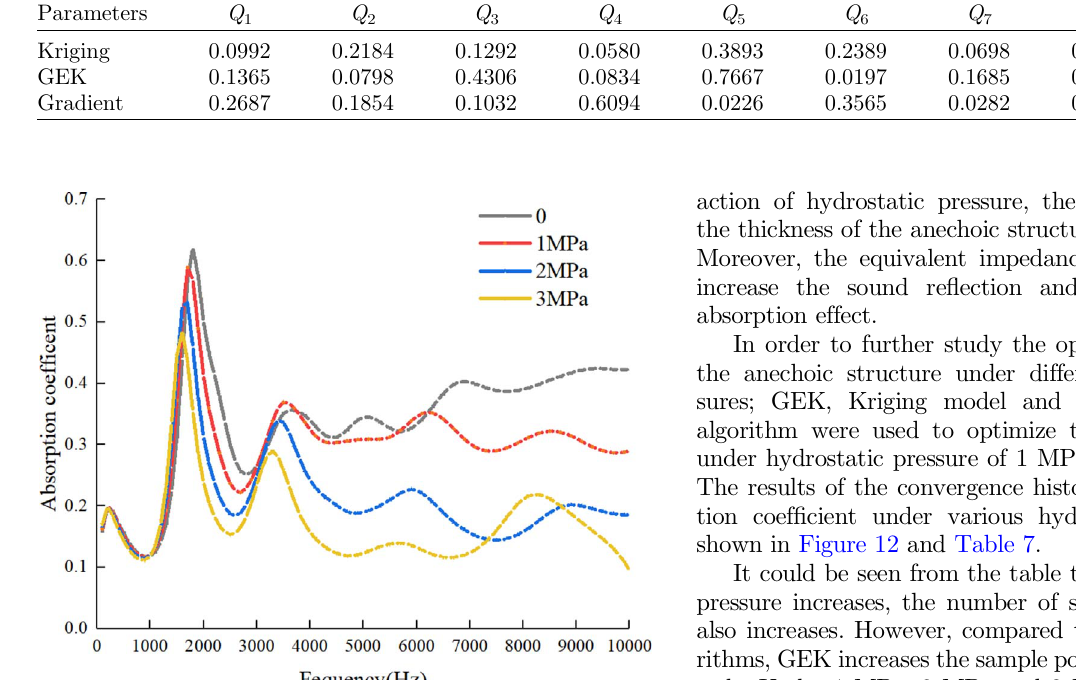
Table 6. The value of each design parameter in the fi nal optimization model at low frequency. Parameters